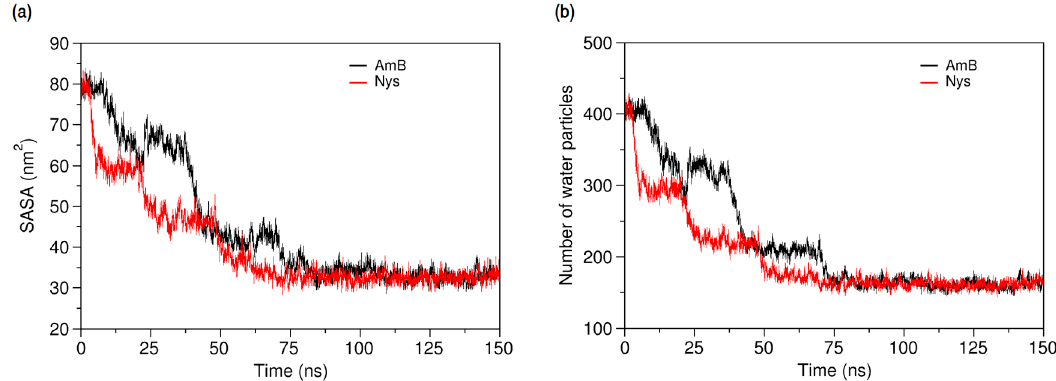
Figure 5. Comparison of the time-evolution of ( a ) solvent accessible surface area (SASA) of AmB and Nys; and ( b ) average number of water particles around AmB and Nys molecules within 7 Å, during self-association process.